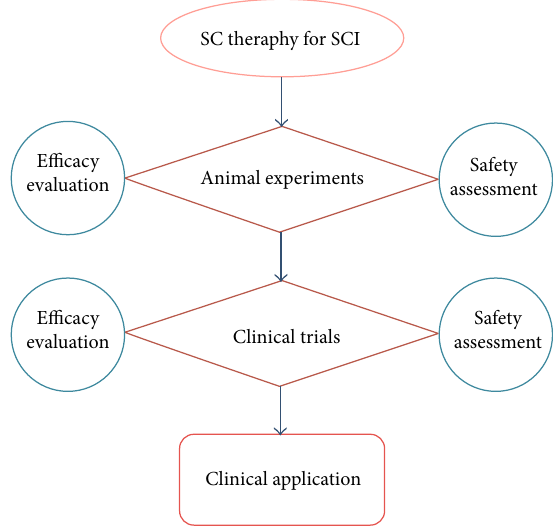
Figure 3: The application process of stem cells (SCs) for spinal cord injury (SCI). SC therapy for SCI must go through animal experiments and clinical trials before it can be applied in the clinic. During this period, the e ffi cacy evaluation and safety assessment should be carried